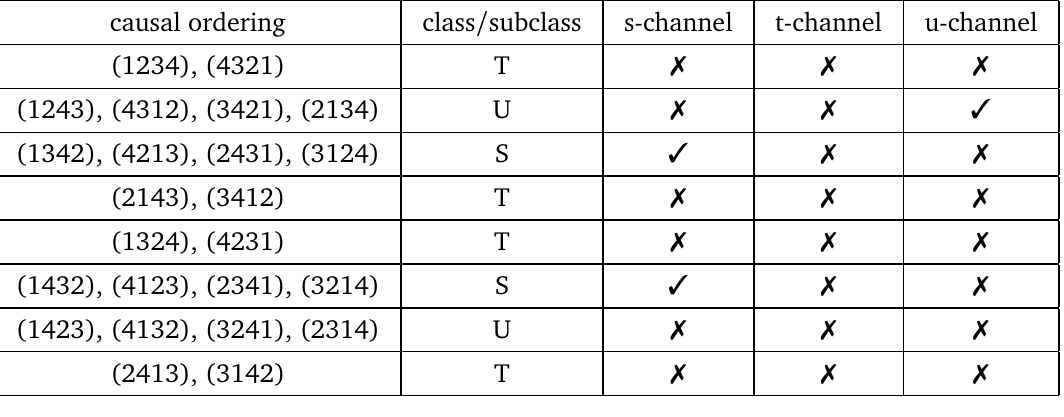
Table 12: OPE convergence properties of type 8 causal orderings causal